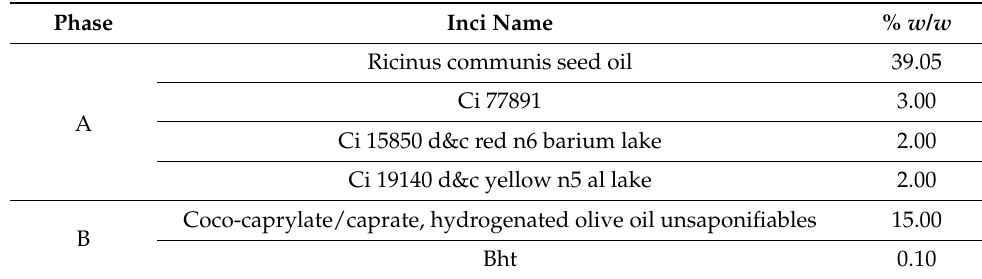
Table 12. Final lipstick formula Ref.